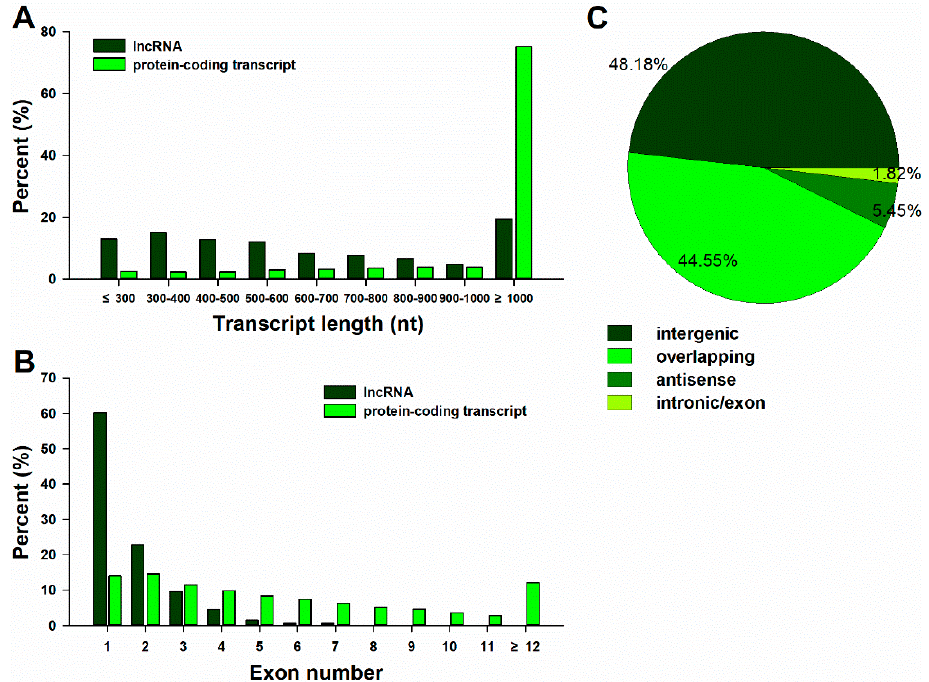
Figure 3. The distribution of the length ( A ) and number of exons ( B ) of lncRNAs in comparison with protein-coding transcripts and classification of lncRNAs ( C ). Protein-coding transcripts according to the Clementine mandarin ( Citrus clementina ) reference sequence. Different types of lncRNAs in the leaf of trifoliate orange, including ‘intergenic’ contained the intergenic lncRNAs, ‘overlapping’ contained the lncRNAs that have generic exonic overlap with a known transcript, ‘antisense’ contained the lncRNAs that have exonic overlap with a known transcript, but on the opposite strand, and ‘intronic/exon’ contained the lncRNAs that have intronic and exon regions of a known transcript.